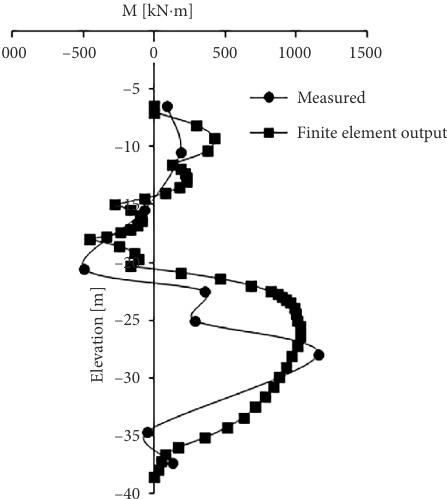
Figure 7. Comparison between finite element output and filed measured bending moment at excavation to –21 m